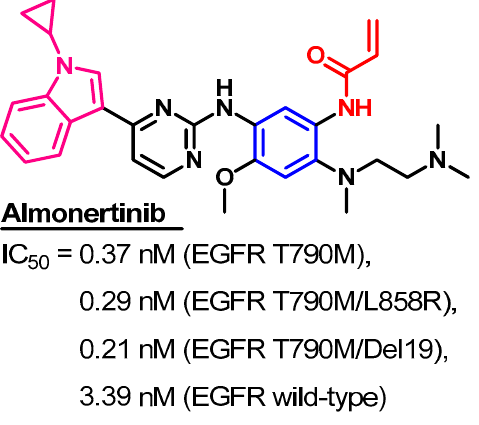
Figure 14. Kinases inhibitory activities of almonertinib.